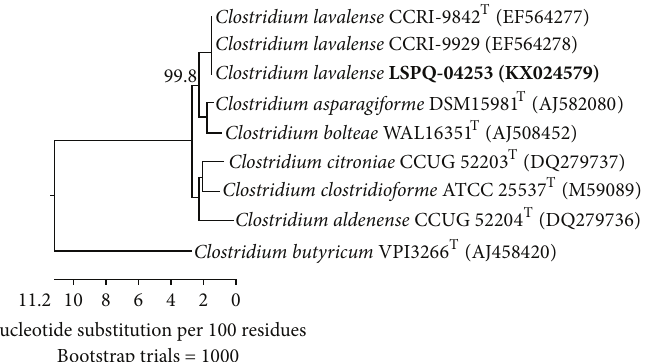
Figure 1: Neighbor-joining phylogenetic tree based on comparison of 16S rRNA gene sequences. Bootstrap percentage is shown at the node. The bar gives the number of nucleotide substitutions per 100 residues.